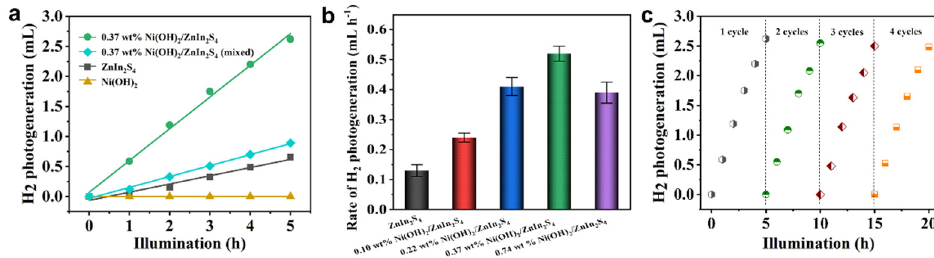
Figure 4. ( a ) H 2 evolution curves versus illumination time of visible light ( λ > 420 nm) of ZnIn 2 S 4 , Ni(OH) 2 , 0.37 wt% - Ni(OH) 2 /ZnIn 2 S 4 , and 0.37 wt%-Ni(OH) 2 /ZnIn 2 S 4 (mixed). ( b ) H 2 evolution rate of ZnIn 2 S 4 , Ni(OH) 2 , and Ni(OH) 2 /ZnIn 2 S 4 with different amounts of Ni(OH) 2 involved. The data were obtained from three individual experiments. ( c ) H 2 evolution stability test of 0.37 wt% Ni(OH) 2 /ZnIn 2 S 4 under the illumination of visible light ( λ > 420 nm).